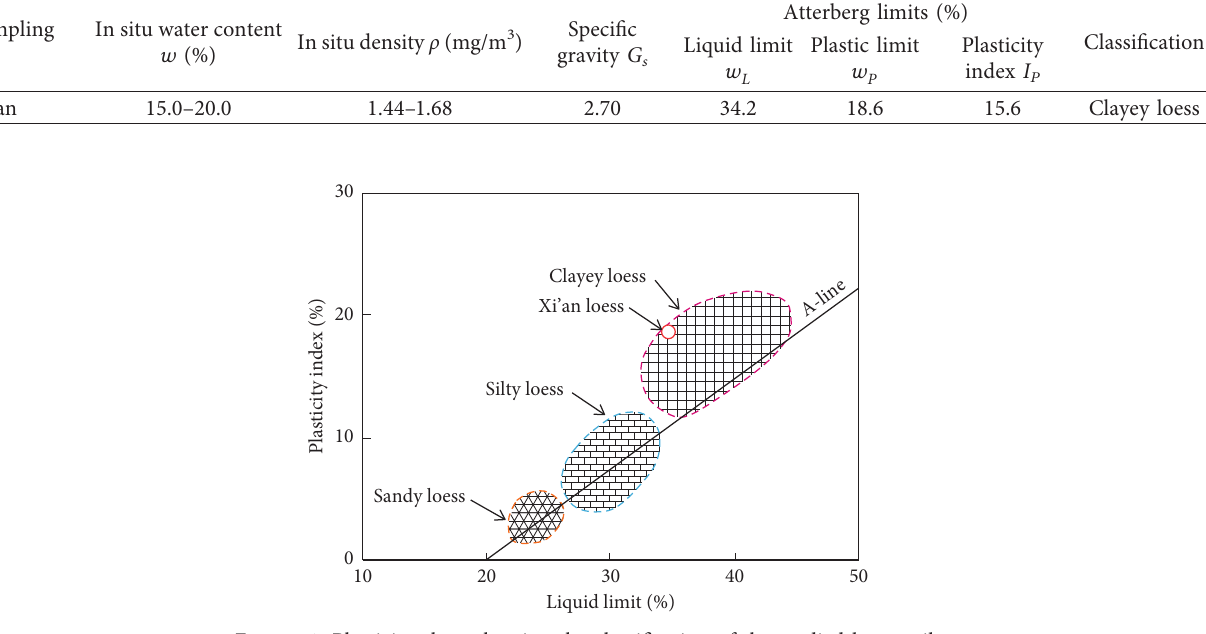
Table 1: Physical properties of the studied loess soil.